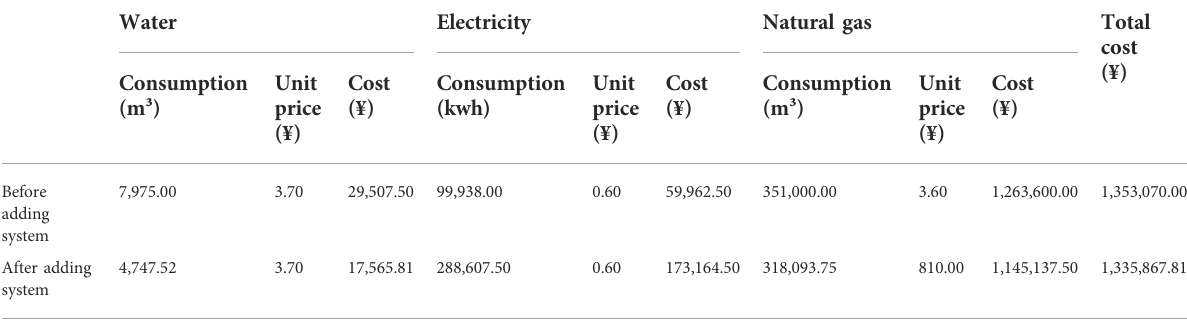
TABLE 11 Material consumption and cost before and after adding the system.